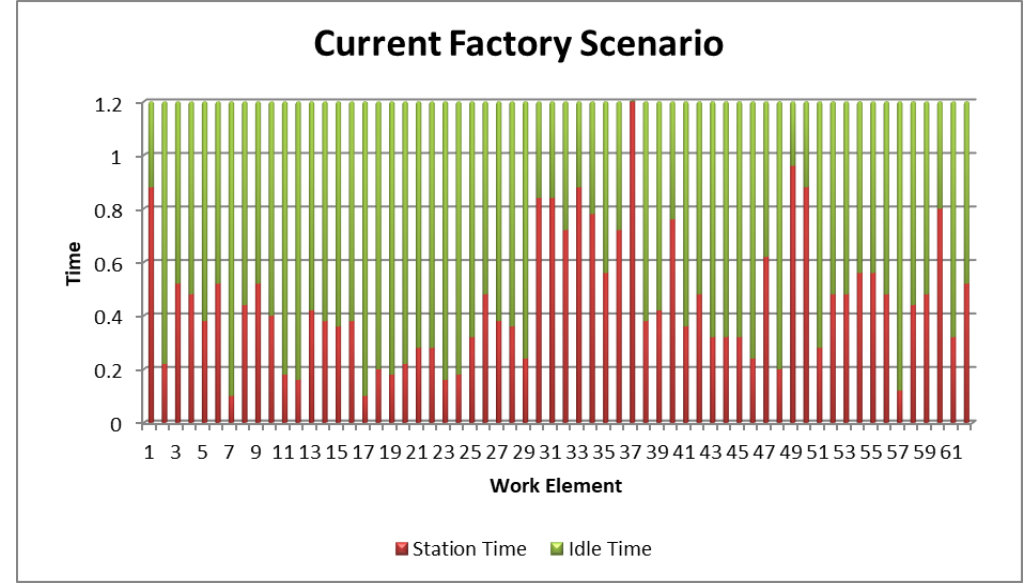
Figure 6. Service time and idle time of current line balancing technique.